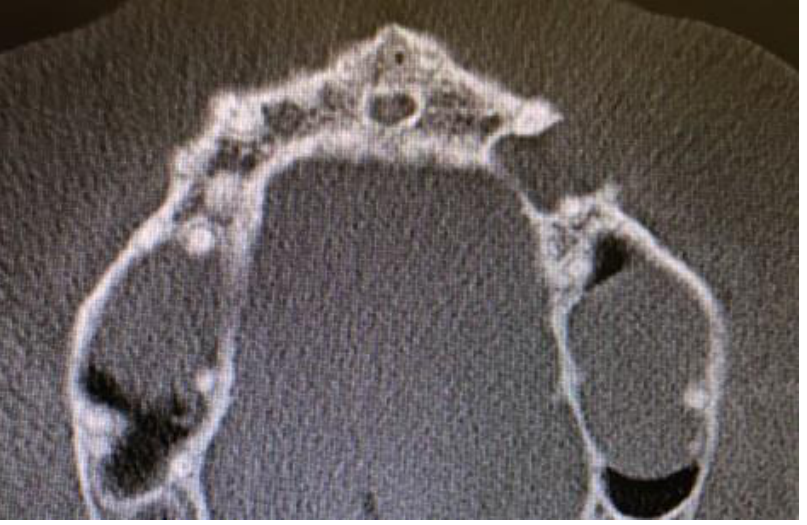
Figure 4. CBCT axial view of LPC, note 23 teeth close to apex relation with lesion.